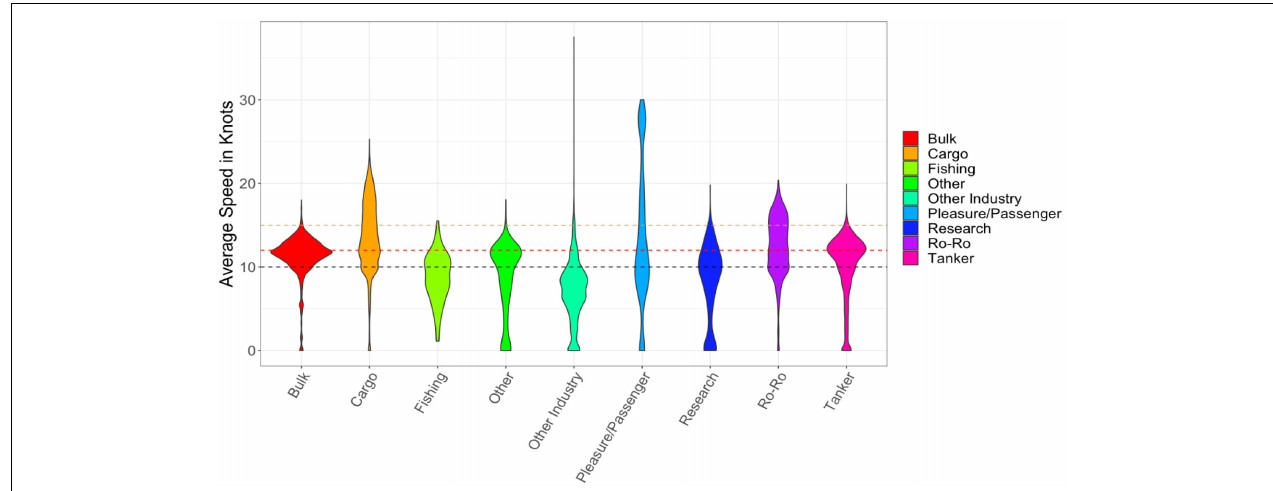
FIGURE 4 | Average speeds of vessels ≥ 300 GT by vessel type, 2010 Southern California Protecting Blue Whales and Blue Skies Program VSR zones 2014, 2016–2019, shown in green. 2019. The width of the filled region of the plots is proportional to the number of transits. Black dotted line represents 10 knots, red line represents 12 knots, and yellow line represents 15 knots. TABLE 2 | Nautical miles traveled, mean speed over ground, and % cooperation of all vessels ≥ 300 GT with voluntary VSR requests across years and across active vs. inactive time periods. Year Voluntary VSR Nautical miles traveled Mean speed over % cooperation (total % change in cooperation, inactive status in voluntary VSR zone ground (kts) distance at 10 kts or less) vs. active time